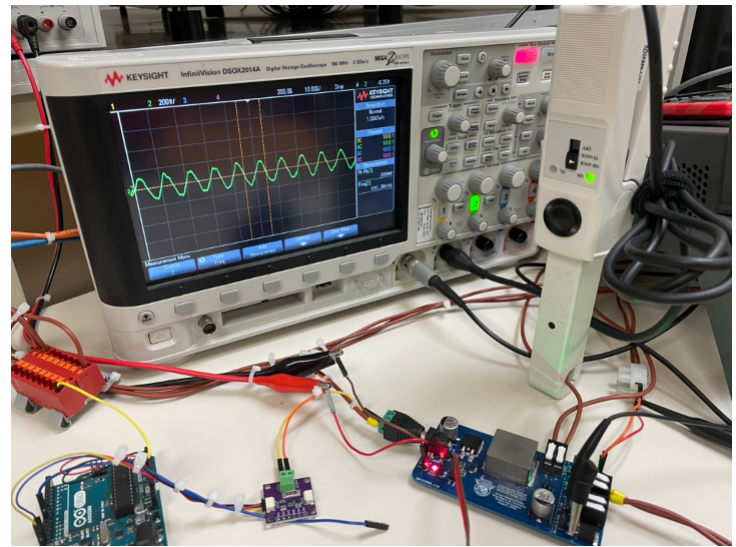
Figure 30. Oscilloscope hall-effect current tip connection for inductance current evaluation.